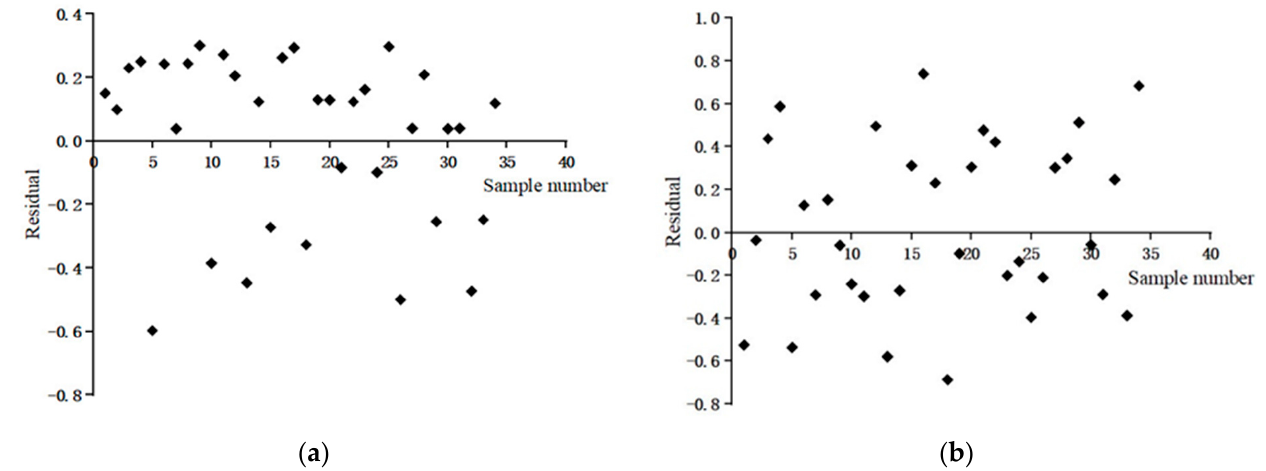
Figure 7. ( a ) The residual distribution map of greenness value for predicted samples based on fluorescence spectral model; ( b ) the residual distribution map of greenness value for predicted samples based on hyperspectral model.